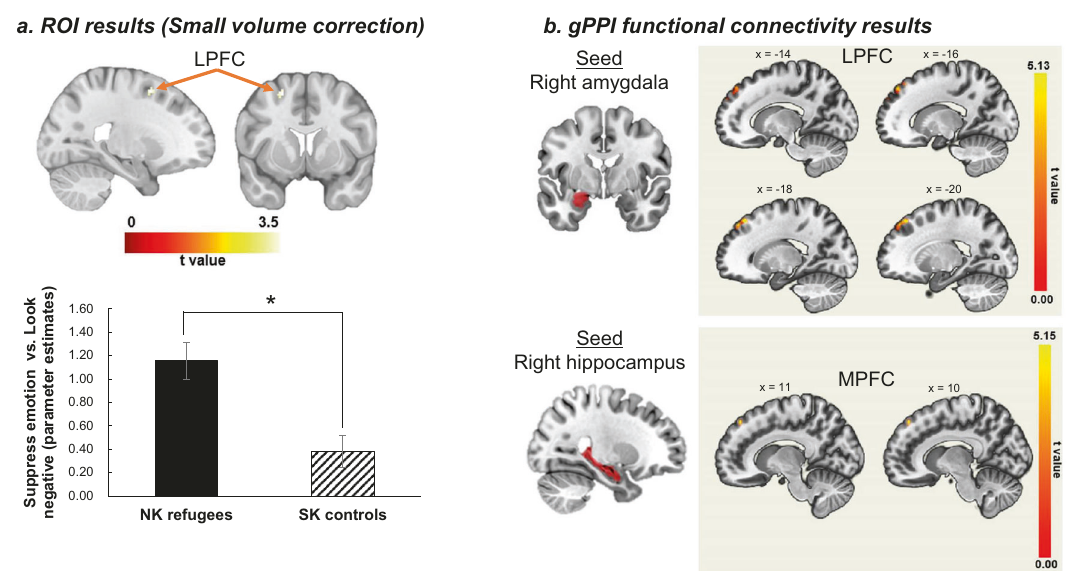
Fig. 2 Neural correlates of emotion regulation. a Left lateral prefrontal cortical (LPFC) activation during emotion suppression (vs. looking at negative pictures) resulted from the small volume correction (SVC) analysis limited to anatomically de fi ned prefrontal ROI masks between NK refugees and SK controls (cluster-de fi ning threshold, p < 0.001; cluster size >25 voxels to achieve a SVC corrected p < 0.05) (* p < 0.05). b Increased functional connectivity (1) between right amygdala (seed) and left LPFC (center coordinate: x = 18, y = 36, z = 52) and (2) between right hippocampus (seed) and MPFC (center coordinate: x = 10, y = 44, z = 48) during emotion suppression (vs. looking at negative pictures) in NK refugees compared to SK controls (FWE corrected threshold of p < 0.05). ROI region of interest, NK North Korean, SK South Korean, gPPI generalized psychophysiological